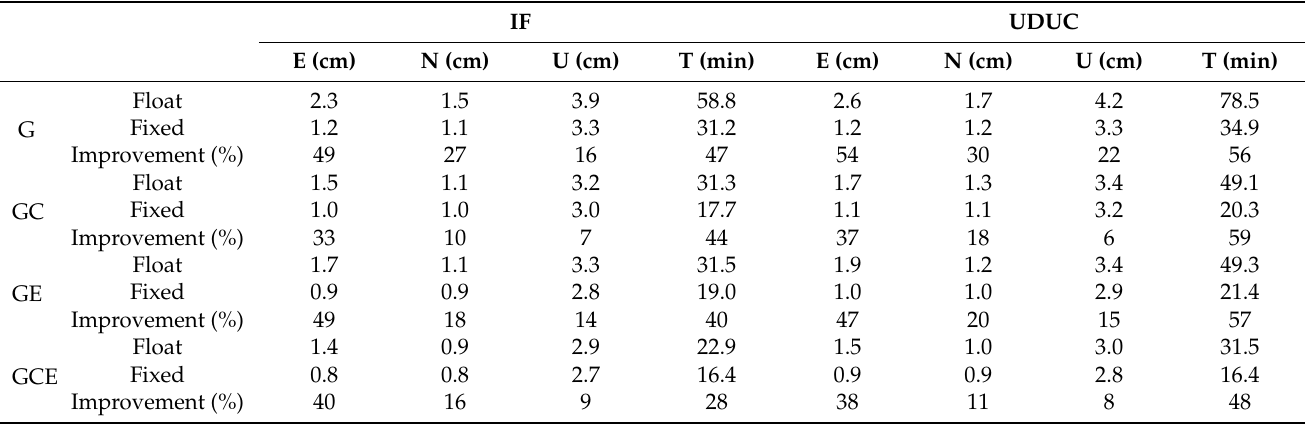
Table 6. The RMS results of position differences and convergence time of the IF model (left) and the UDUC model (right) G, GC, GE, and GCE kinematic float/fixed PPP on DOY 300-306, 2021, for 22